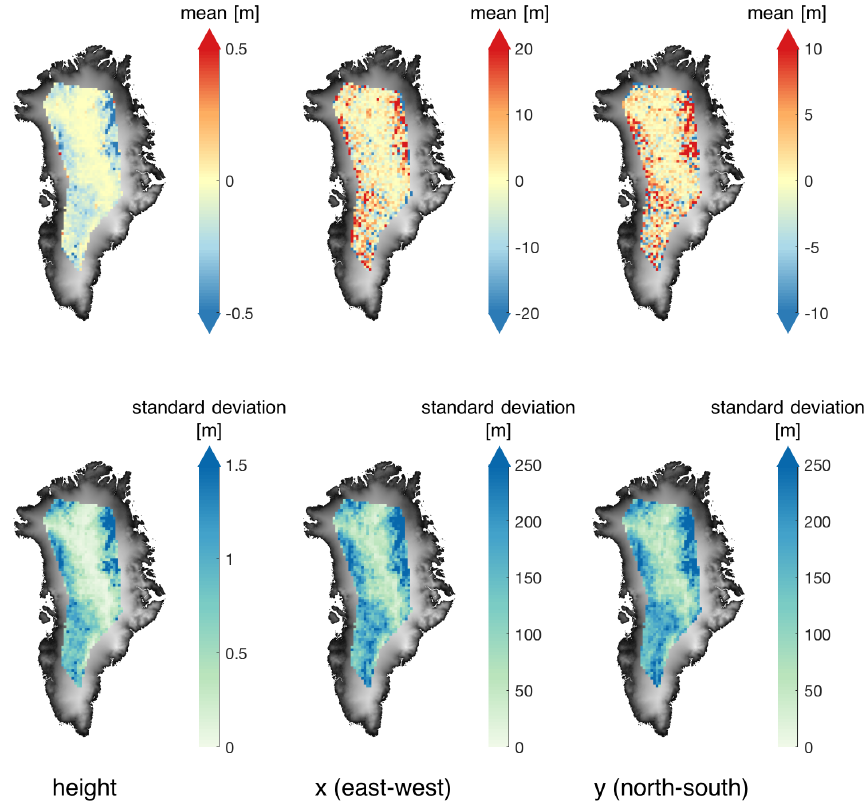
Figure 6. Mean and standard deviation of the differences between the height and horizontal location of the impact point obtained using (cid:49)r = 2m ( (cid:49)r 2 ) and (cid:49)r = 1m ( (cid:49)r 1 ). The mapped locations are based on the horizontal locations ( x and y ) derived from (cid:49)r 1 , tiled by the 25km × 25km grid as in Fig. 4.